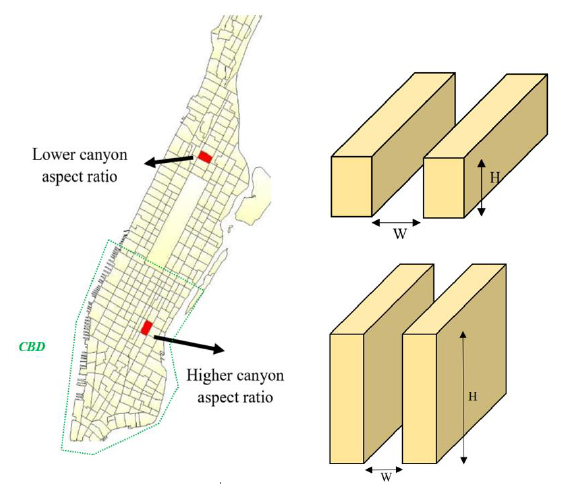
Figure 11. Sample locations of workplaces for evaluating indoor